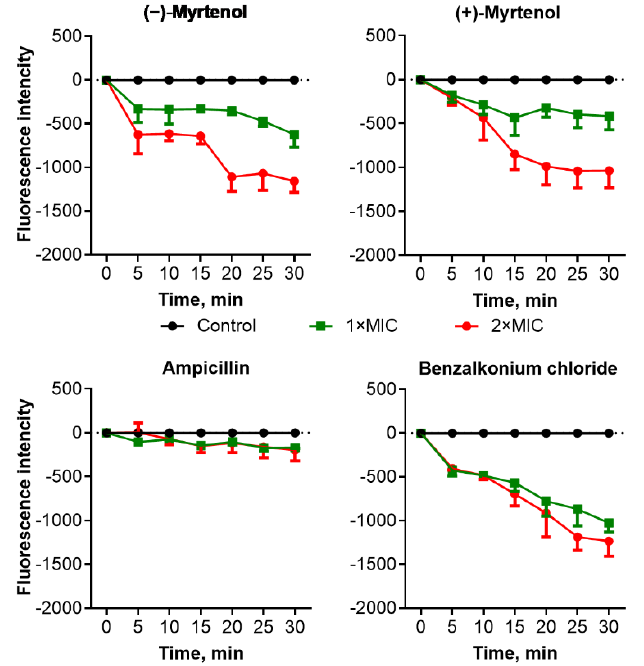
Figure 2. Relative membrane potential of S. aureus cells expressed in fluorescence units of DioC2(3) reduced on an intact cell membrane resulting in green fluorescence. Cells were grown for 18 h in LB broth, washed with PBS, and resuspended until a final density of 10 6 CFU/mL in PBS supplemented with DioC2(3) to a final concentration of 10 μM/mL. After a 30 min incubation at 25°C, compounds of interest were added to the samples. Fluorescence detection was performed for 30 min with 5 min intervals with excitation and emission wavelengths of 497 and 520 nm, respectively.